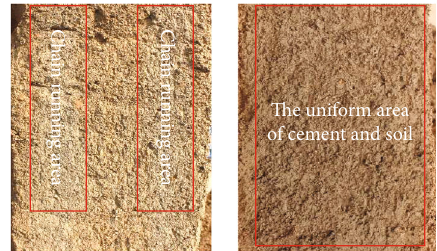
Figure 13: Distribution of cement with di ff erent mixing time.